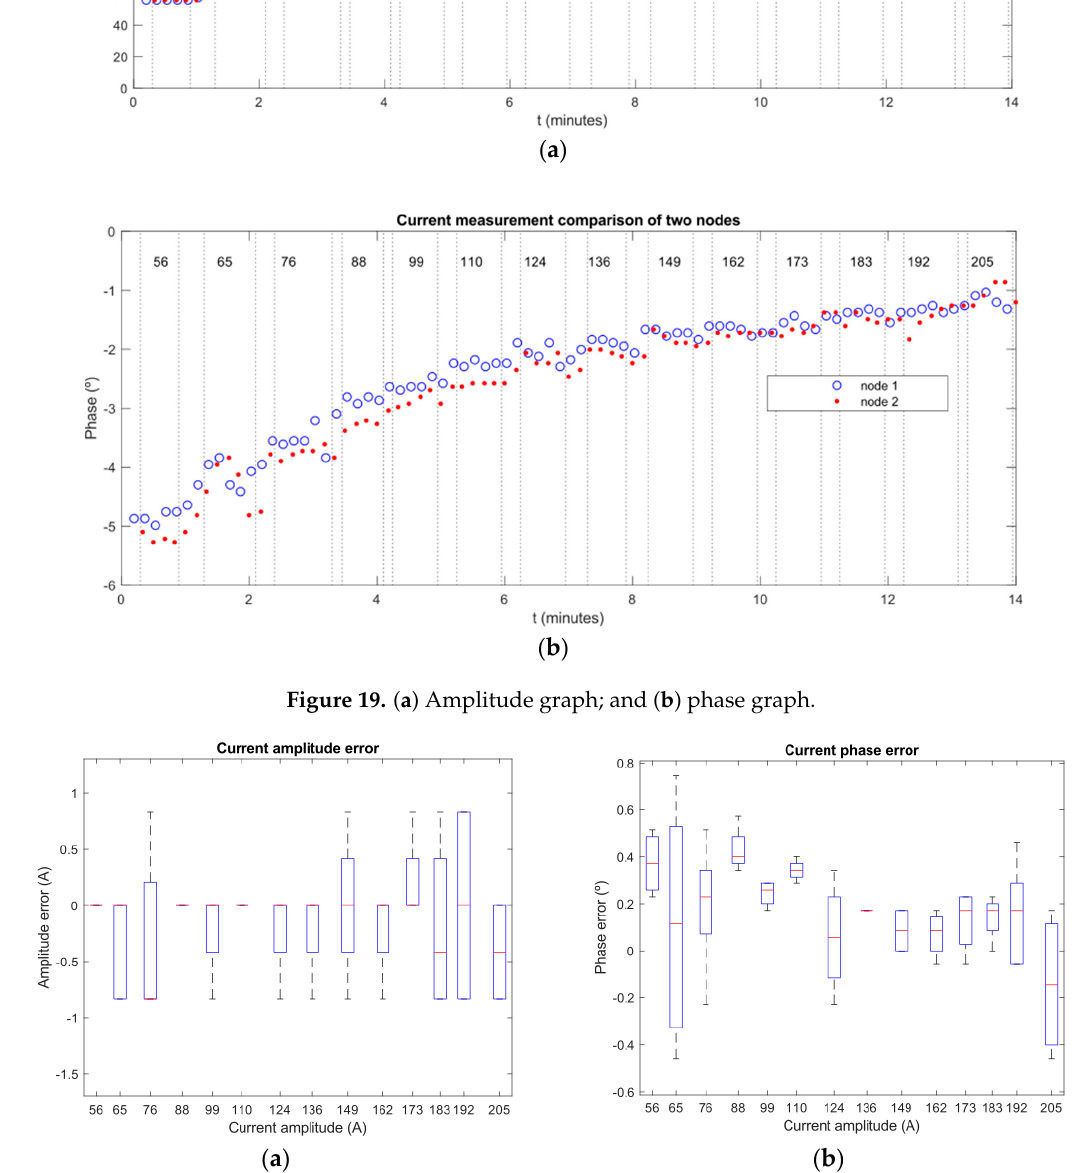
Figure 20 . ( a ) Amplitude error; and ( b ) phase error. Figure 20. ( a ) Amplitude error; and ( b ) phase